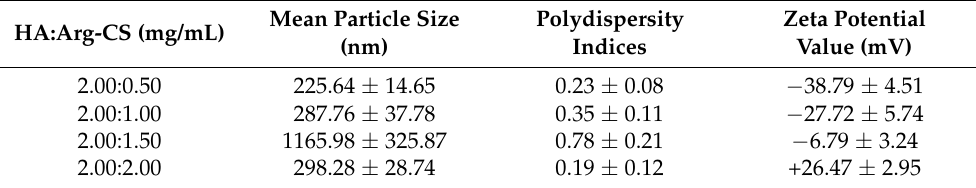
Table 1. Characteristics of prepared NPs constructed with differential HA:Arg-CS concentrations.